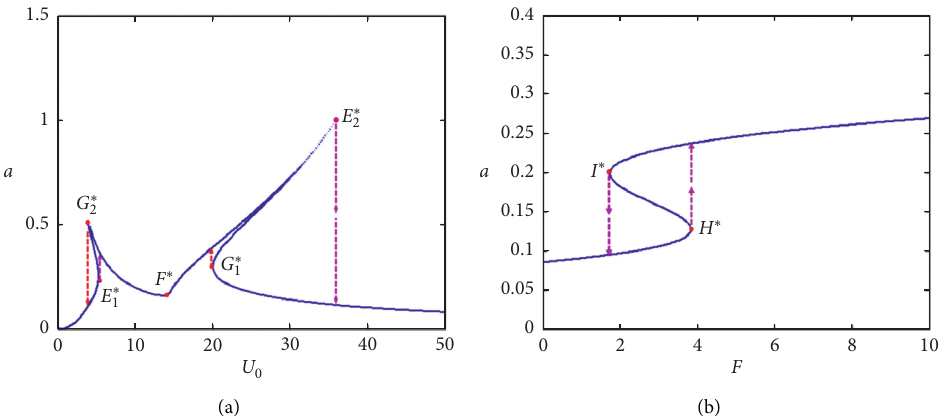
Figure 5: The amplitude-frequency response curves of the cantilevered pipe conveying pulsating fluid are obtained. (a) Amplitude-response curves on flow velocity; (b) amplitude-response curves on external